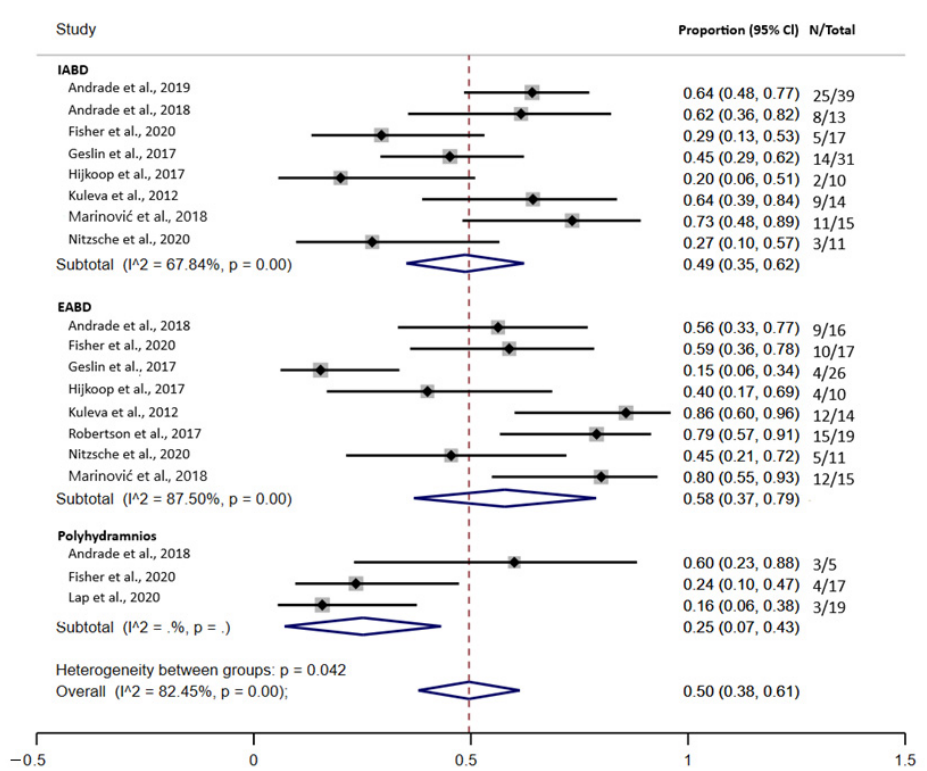
Figure 5. Forest plot of the prediction of complex gastroschisis with intraabdominal bowel dilatation (IABD), extra-abdominal bowel dilatation (EABD), and polyhydramnios.